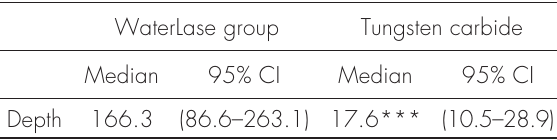
Table III. Comparison of depth of removal between groups: medians and 95% confidence intervals in ten WaterLase Biolase® and ten tungsten carbide